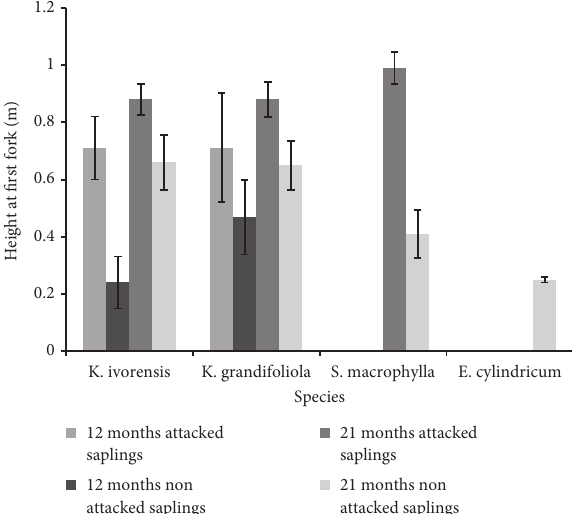
Figure 4: Mean height to the first fork of the attacked and nonattacked saplings of the four Meliaceae species 12 and 21 months after planting in the moist semideciduous forest.